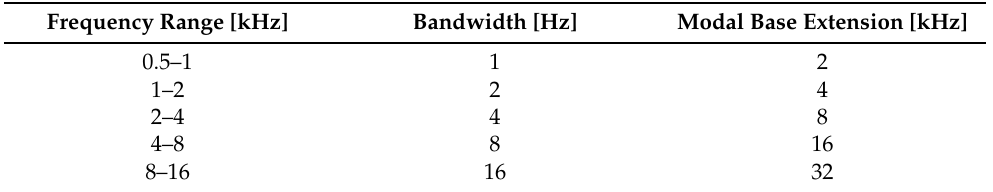
Table 2. Analysis